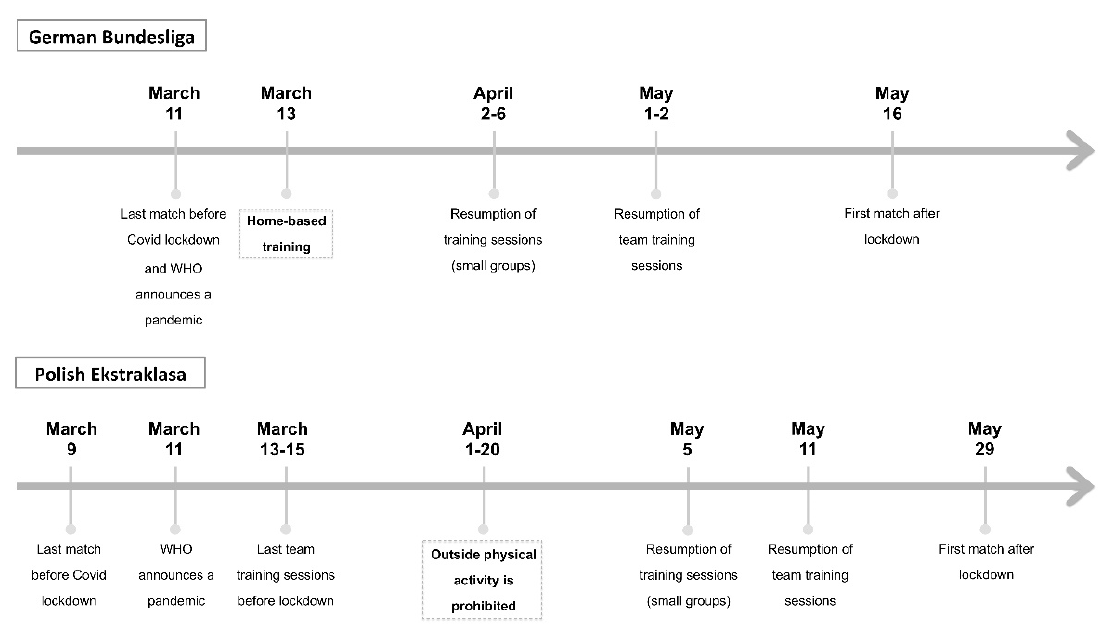
Figure 1. Time schedule involving important dates of COVID-19 lockdown in Germany and Poland.